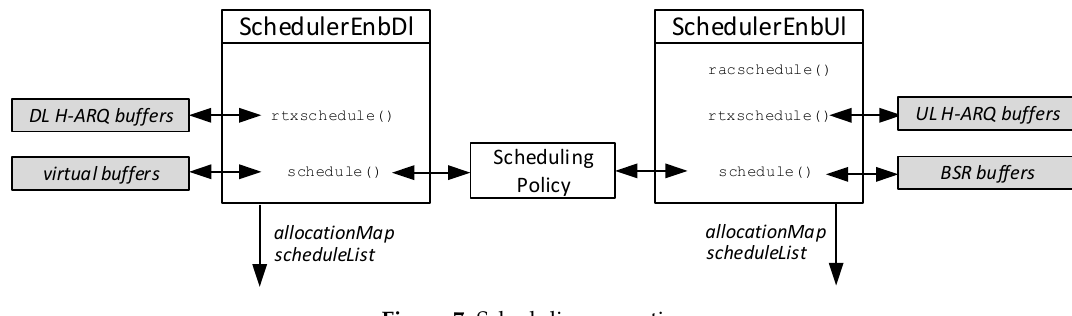
Figure 7. Scheduling operations.